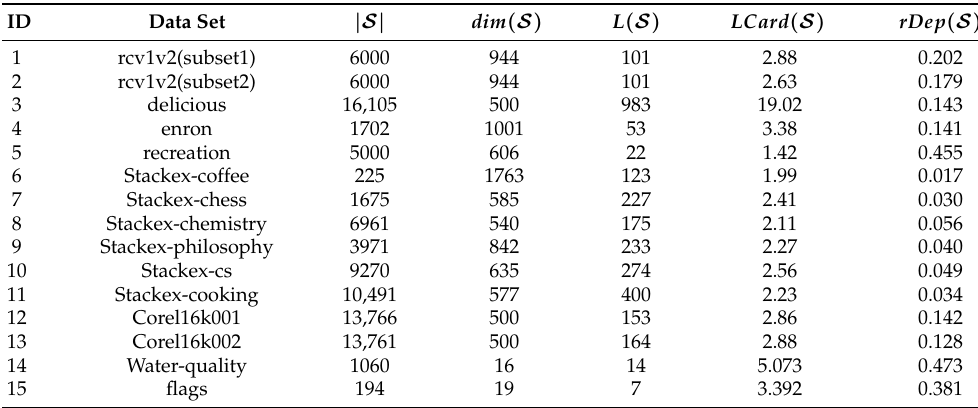
Table 1. Description of